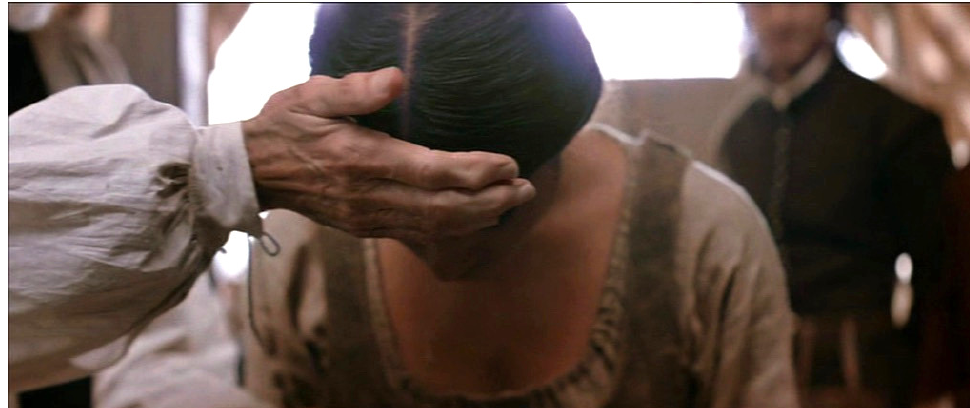
Figure 12: The captured Smith is taken through a religious or cultural ceremony.